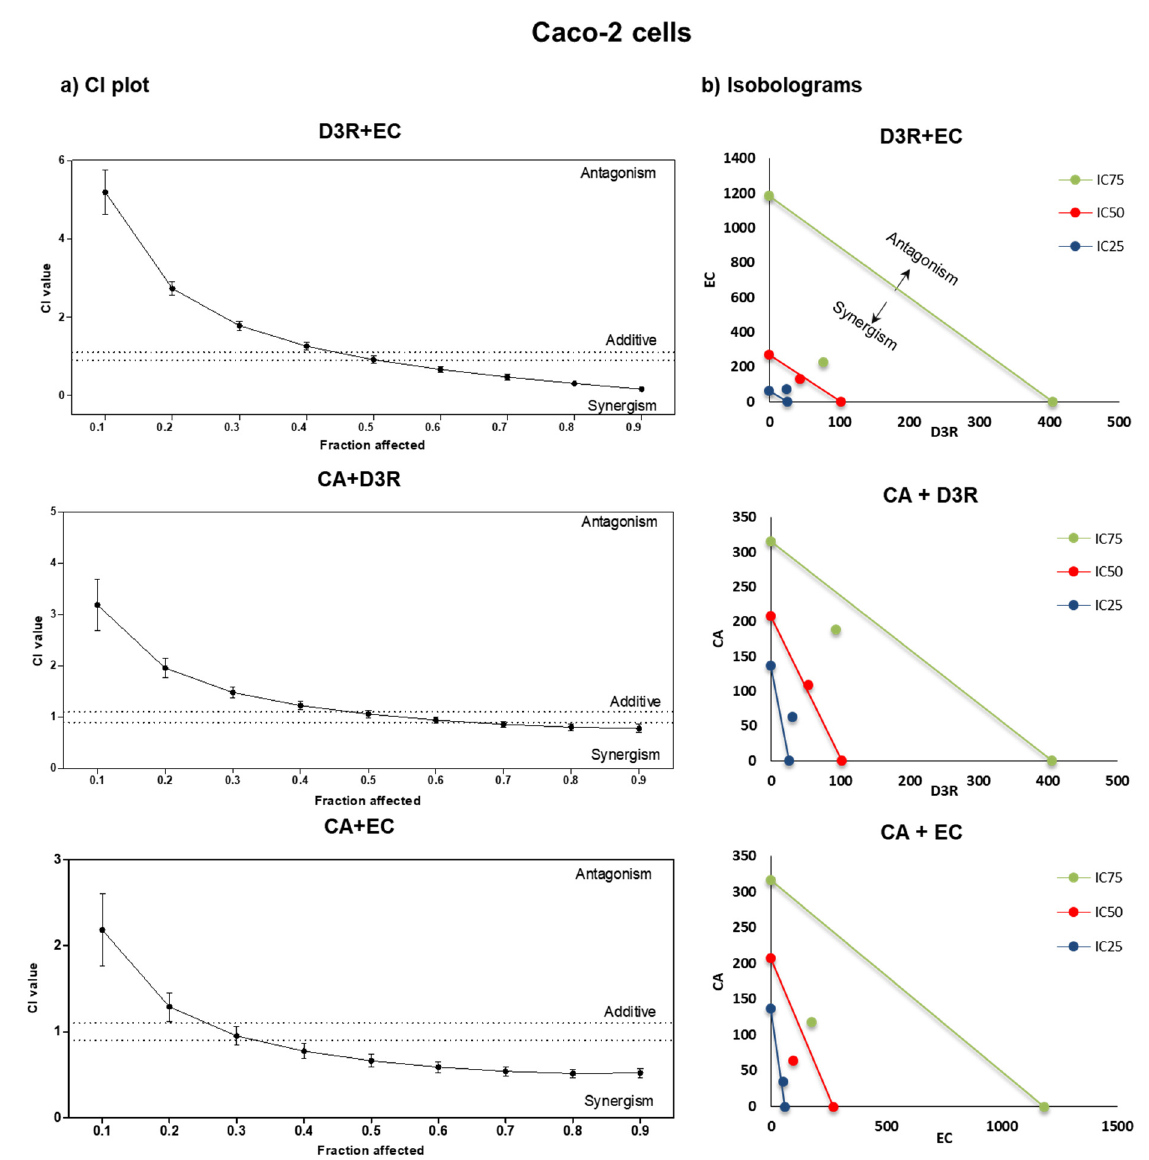
Figure 3. CI-plots ( a ) and isobolograms ( b ) of D3R, CA, and EC binary combinations: D3R+EC, D3R+CA, and CA+EC after exposure on Caco-2 cells. The CI values were obtained from three independent experiments (quadruplicates); the vertical bars on CI-plots indicate 95% confidence intervals for CI values based on sequential deletion analysis [19] . Table 2. Dose-effect parameters (r, m, D m ), combination index (CI), and dose reduction index (DRI) values for combinations of polyphenols towards NCI-N87 and Caco-2 cells proliferation. Dose-effect parameters for individual exposure of polyphenols on NCI-N87 and Caco-2 cells.